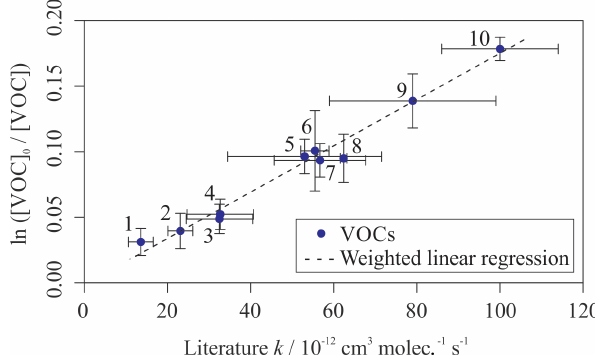
Figure 1. Relative rate plot for Mixture 1 (OH reactivity of 48s − 1 ) in the absence of NO at 296 ( ± 2)K. Compounds with a reference rate coefficient for reaction with OH using evaluated literature val- ues. Error bars on the y axis, equal to 1 standard error, were calcu- lated by combining the standard error in peak areas for eight lamp- off and eight lamp-on samples. Error bars on the x axis were typ- ically large (approximately ± 20%–30%) and accounted for devi- ations from the predicted trend for all VOCs. A weighted (to the uncertainty in the y values) linear fit was used to generate the slope with OH exp = 1 . 8 ( ± 0 . 1 ) × 10 9 molec.cm − 3 s and R 2 = 0 . 980. The VOCs can be identified as follows: 1, o -xylene; 2, m -xylene; 3, 1,2,4-trimethylbenzene; 4, 1,2,3-trimethylbenzene; 5, α -pinene; 6, 1,2,4,5-tetramethylbenzene; 7, 1,3,5-trimethylbenzene; 8, 1,2,3,5- tetramethylbenzene; 9, β -pinene; 10,